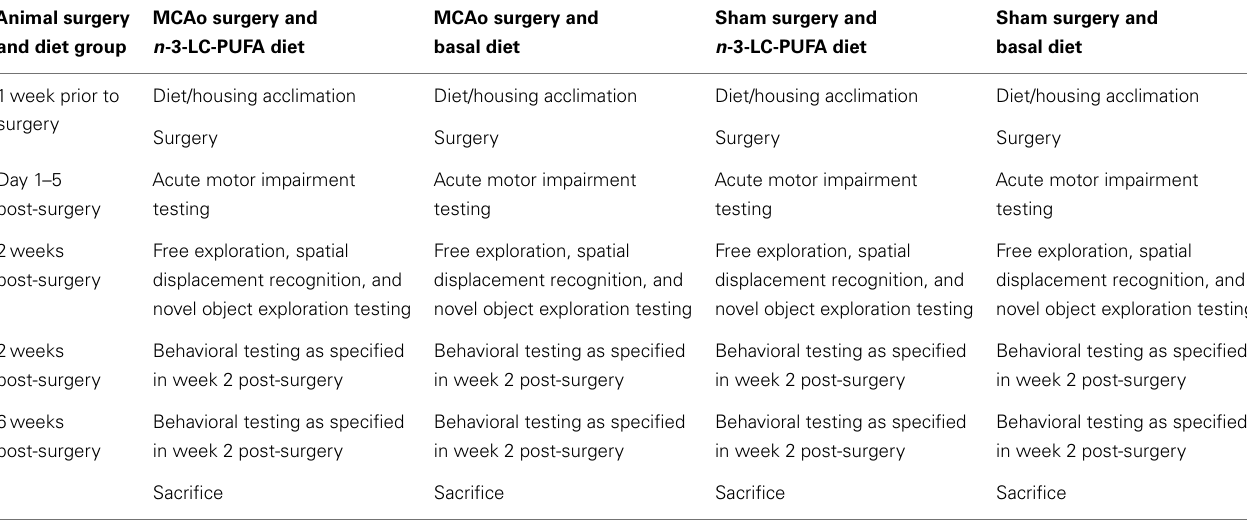
Table 1 | Experimental timeline showing order and timing of treatment and